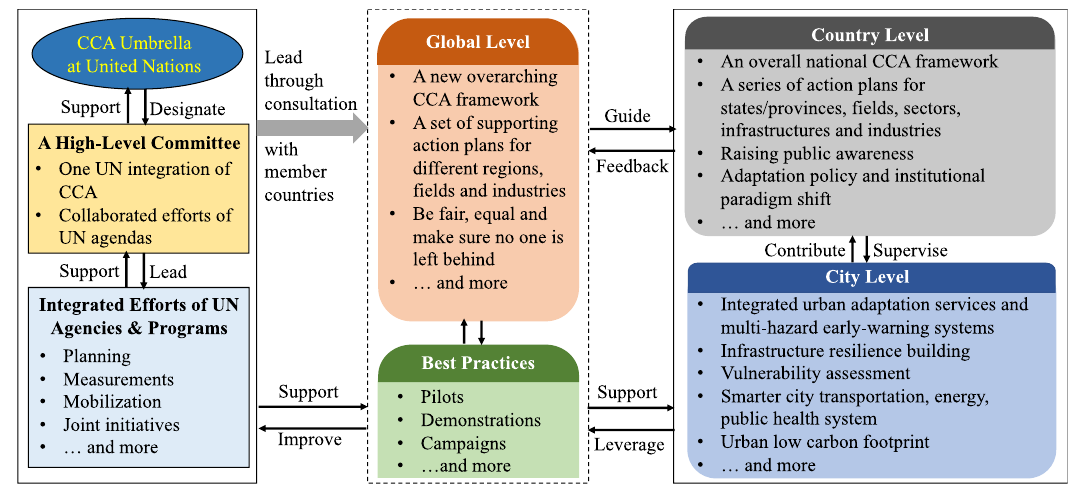
Fig. 3 Recommendations for climate resilient development (CRD) through collaborative governance for climate change adaptation (CCA), with the support of multi-stakeholder